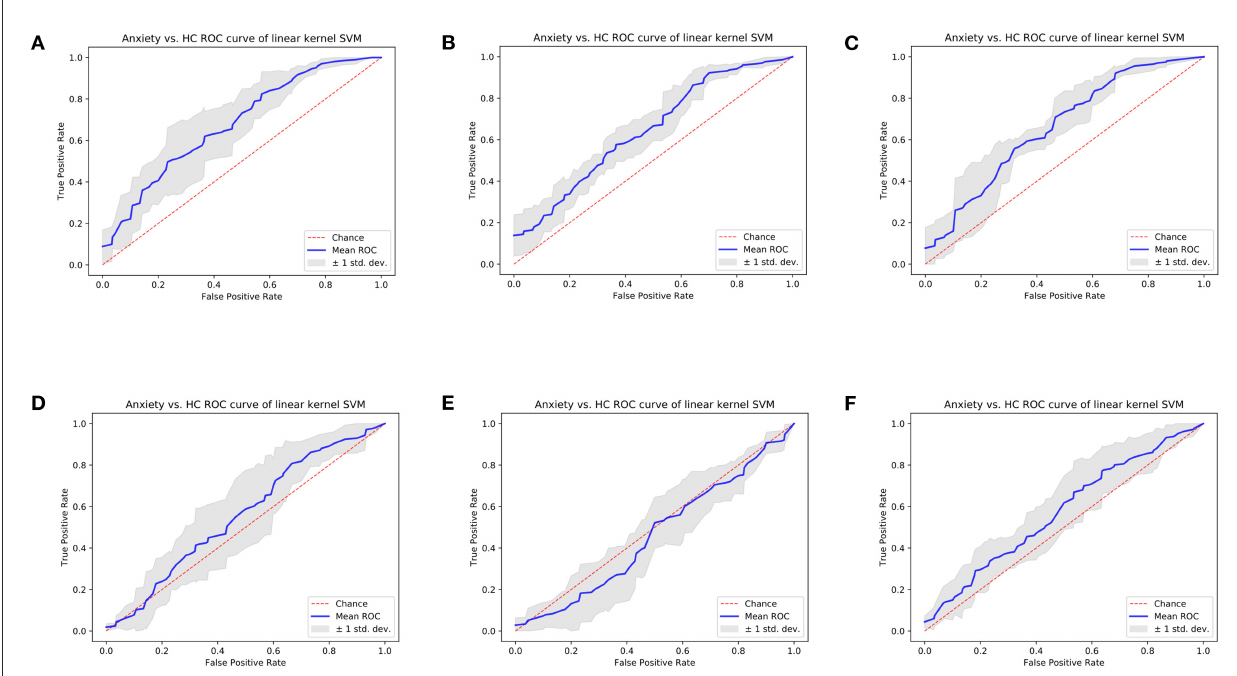
FIGURE4 Cross-validation ROC curves of linear kernel SVM model of Anxiety disorder vs. HC classification task. (A) Model trained using left amygdala radiomics features, (B) model trained using right amygdala radiomics features, (C) model trained using bilateral amygdala radiomics features, (D)